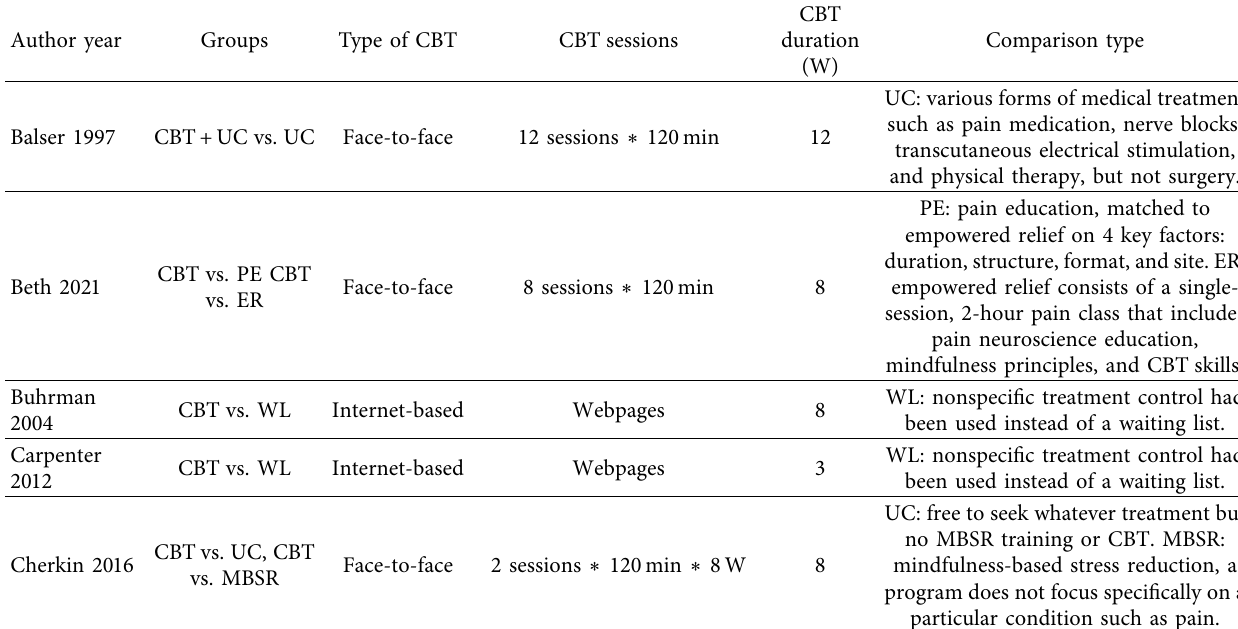
Table 2: CBT and comparison group